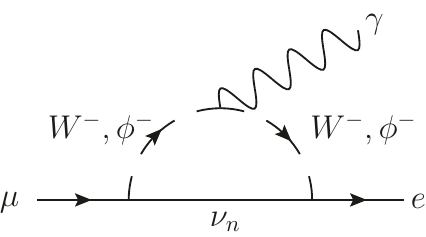
e(cid:13) . Here (cid:23) n refers to the !